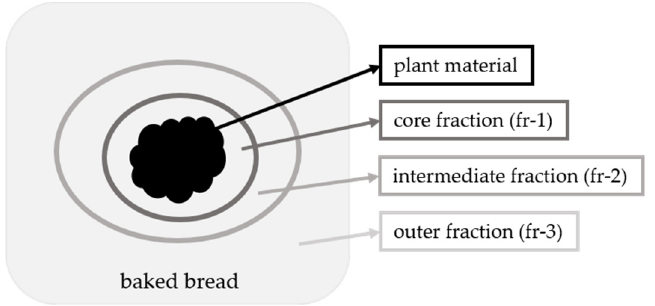
Figure 2. Scheme of the vegetable-enriched model bread application No III (bolus application). The crumb is separated into three fractions: core fraction (fr-1), intermediate fraction (fr-2), and outer fraction (fr-3).